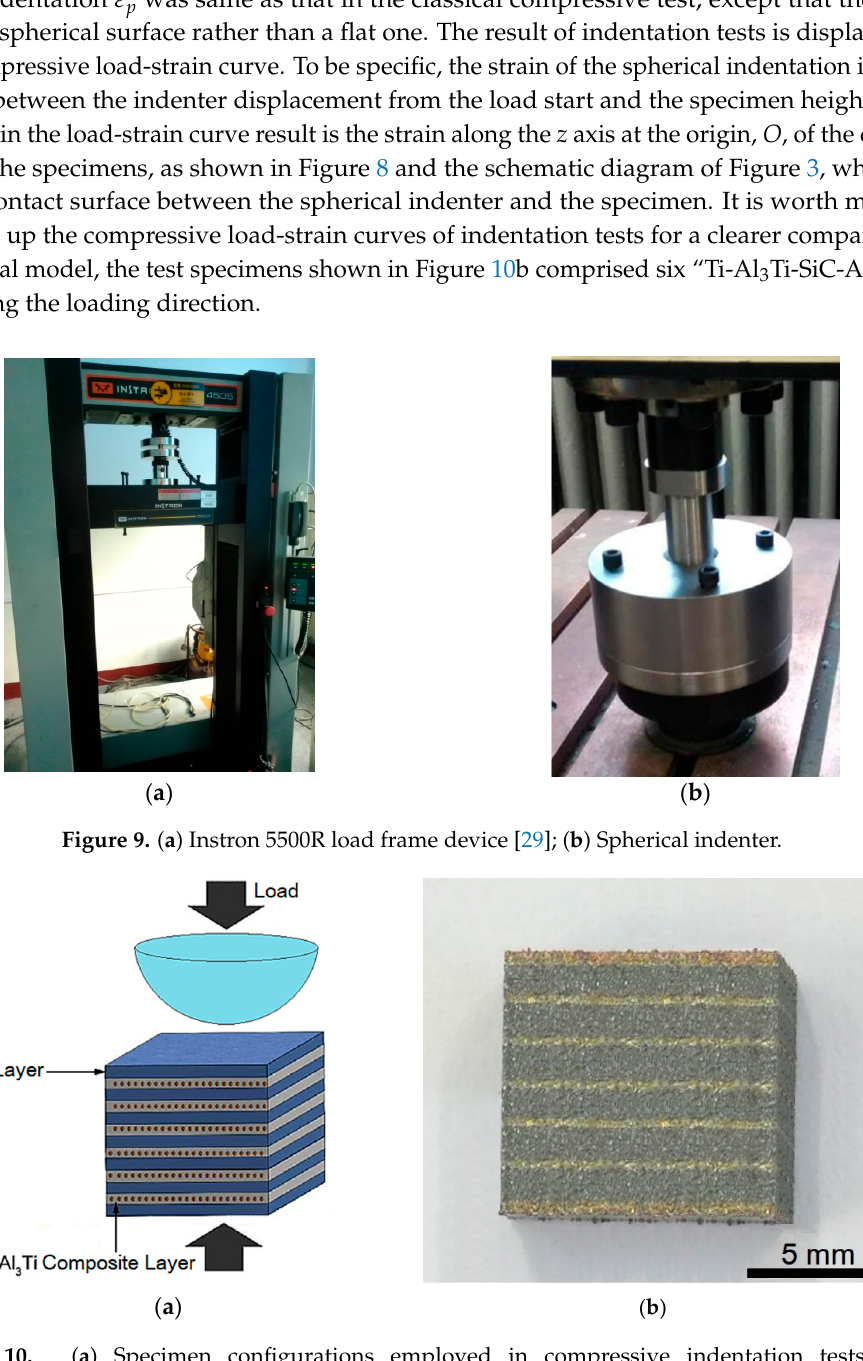
Figure 10. ( a ) Specimen configurations employed in compressive indentation tests [29]; ( b ) Metallographic specimen configuration of Ti-(SiC f /Al 3 Ti) composite with double layered SiC fiber reinforcements.